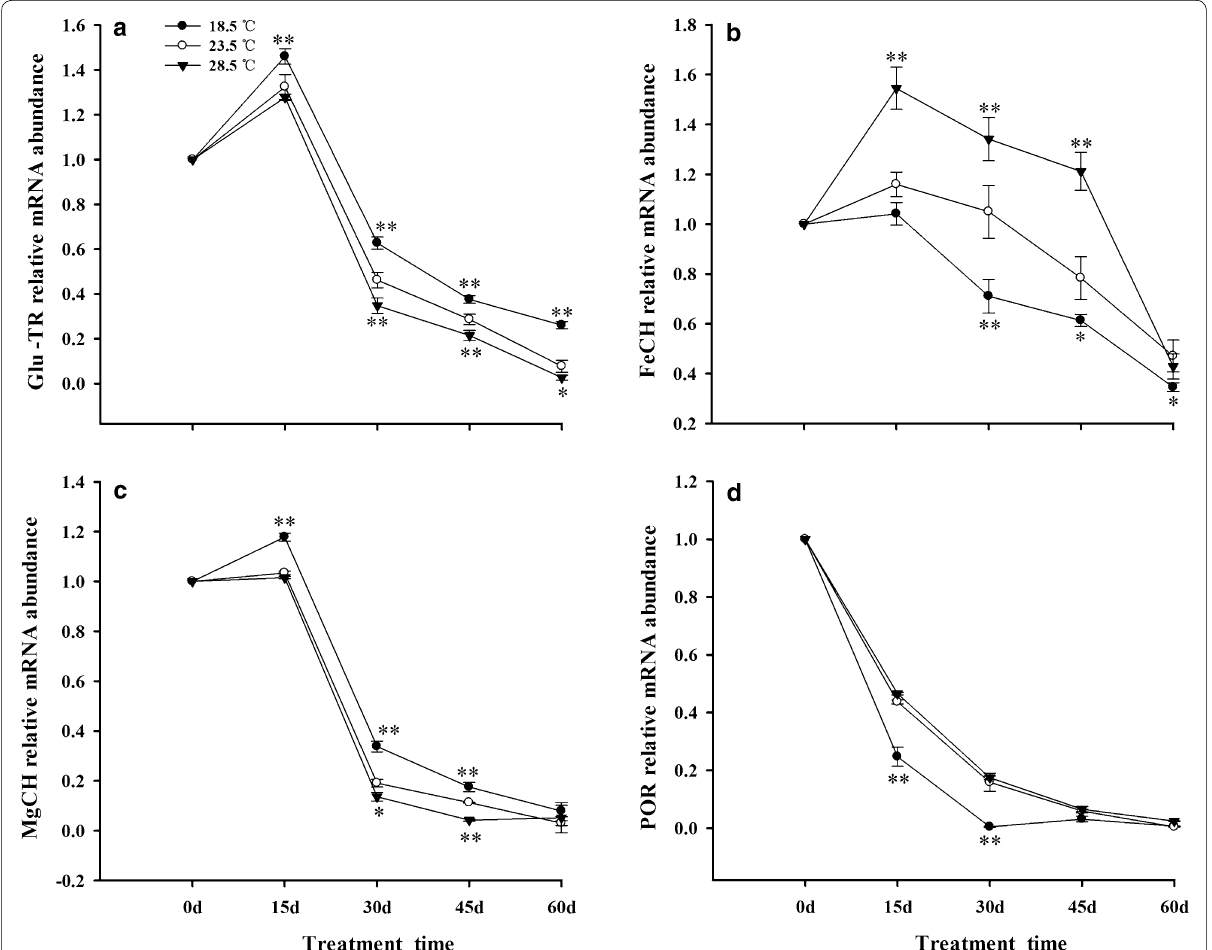
Fig. 6 Effects of different growth temperatures on expression of Chls biosynthesis related-genes in tobacco leaves. Glu-TR ( a ); FeCH ( b ); MgCH ( c ); and POR ( d ),